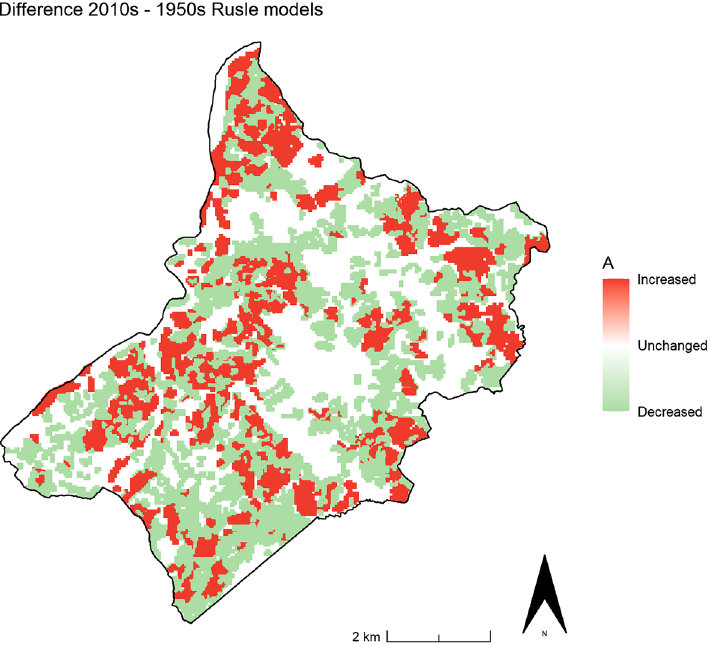
Figure 13. The comparison between the 2010s and the 1950s HLC-RUSLE models highlights zones where A increased/decreased or remained unaltered). Image generated with software RStudio Desktop 2022.07.2 + 576 (https:// www. rstud io.